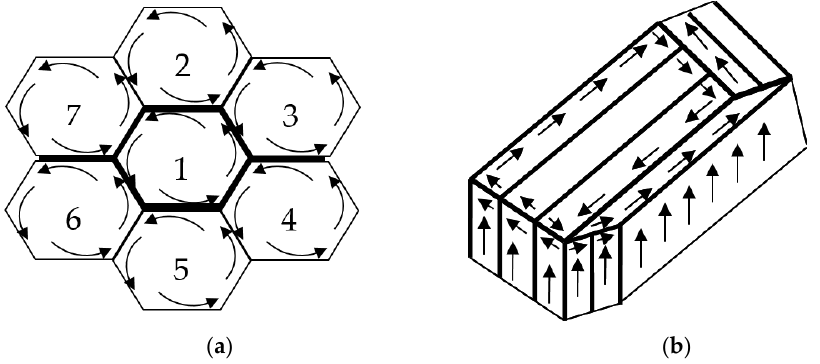
Figure 8. Patterns of superplastic material deformation micro mechanisms of (( a ), 1–6 grain numbers) and patterns obtained after the additional impulse loads application ( b ).